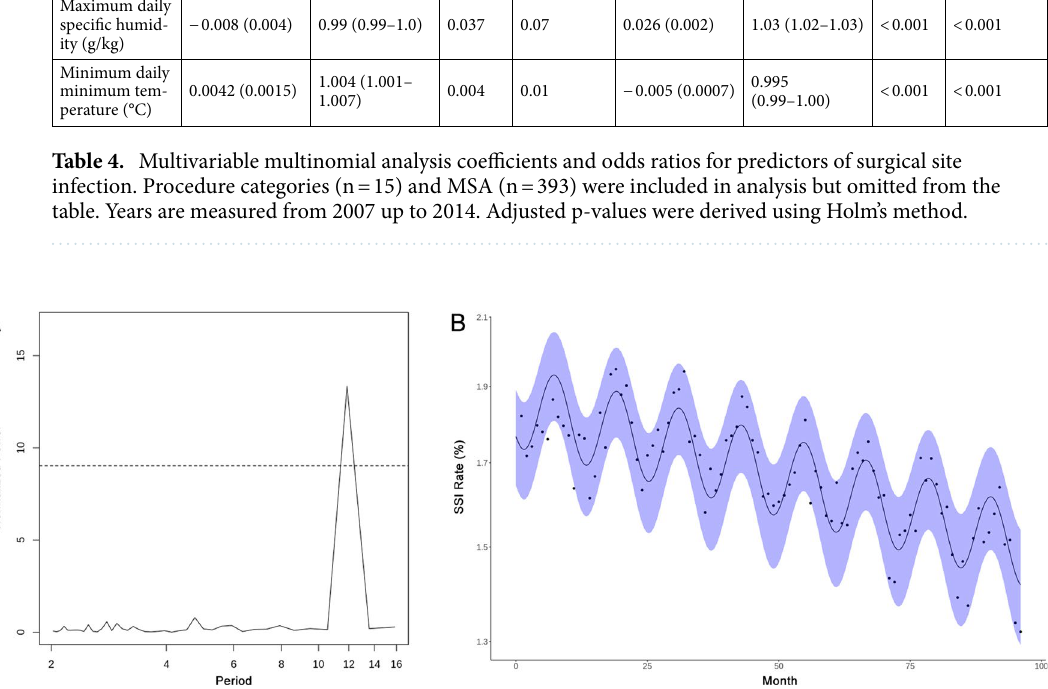
Figure 1. ( A ) Lomb-Scargle periodogram showing significant ~ 12 month periodicity for surgical site infections across the continental United States. Points above the dotted line show significance of p < 0.05. ( B ) Non-linear regression modeling of SSI seasonality. The x-axis represents how many months have passed since January 2007. The shaded blue area represents the model 95%